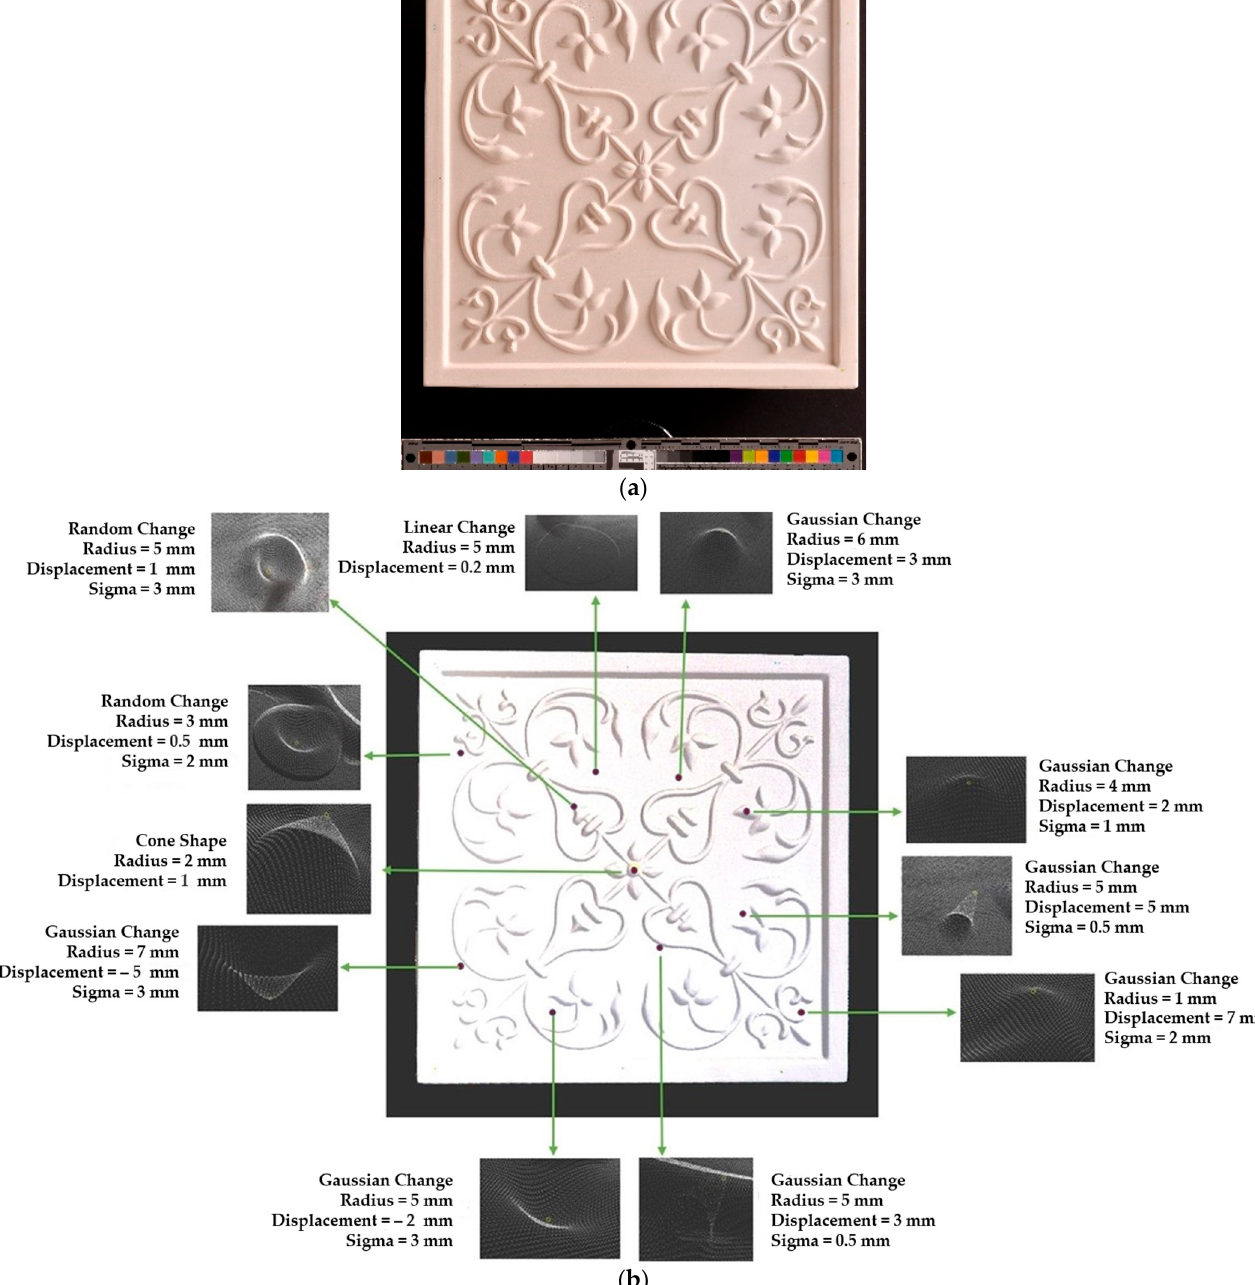
Figure 10. Tile reconstruction; ceramic; 220 × 220 × 45 mm. Owner: Academy of Fine Arts in Warsaw, Poland. ( a ) Original state of the tile and ( b ) changes introduced manually to the original surface. Table 5. Calculated and user input parameters for Case Study I.